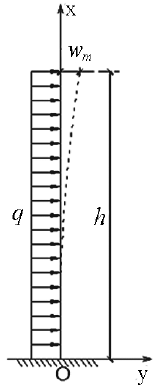
Fig. 2. Size of cantilever pile under the action of uniformly dstributed